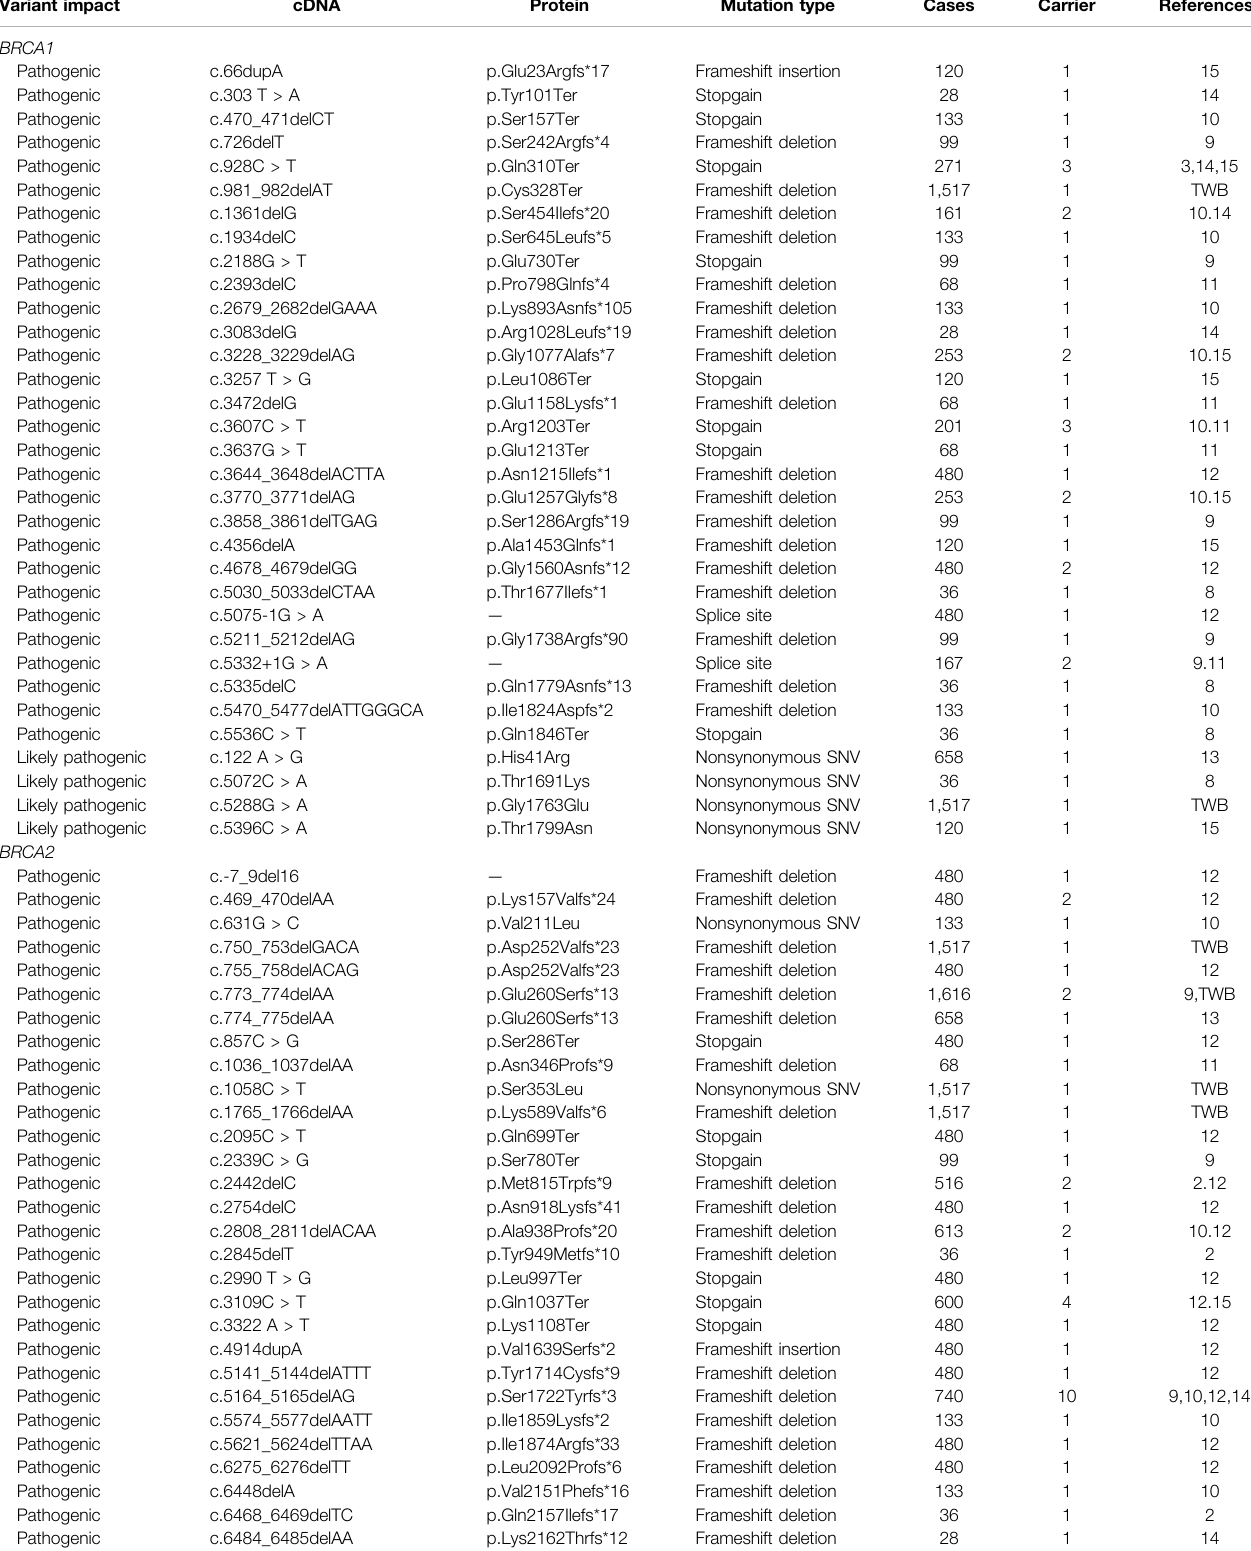
TABLE 4 | BRCA pathogenic and likely pathogenic variants identi fi ed in Taiwanese